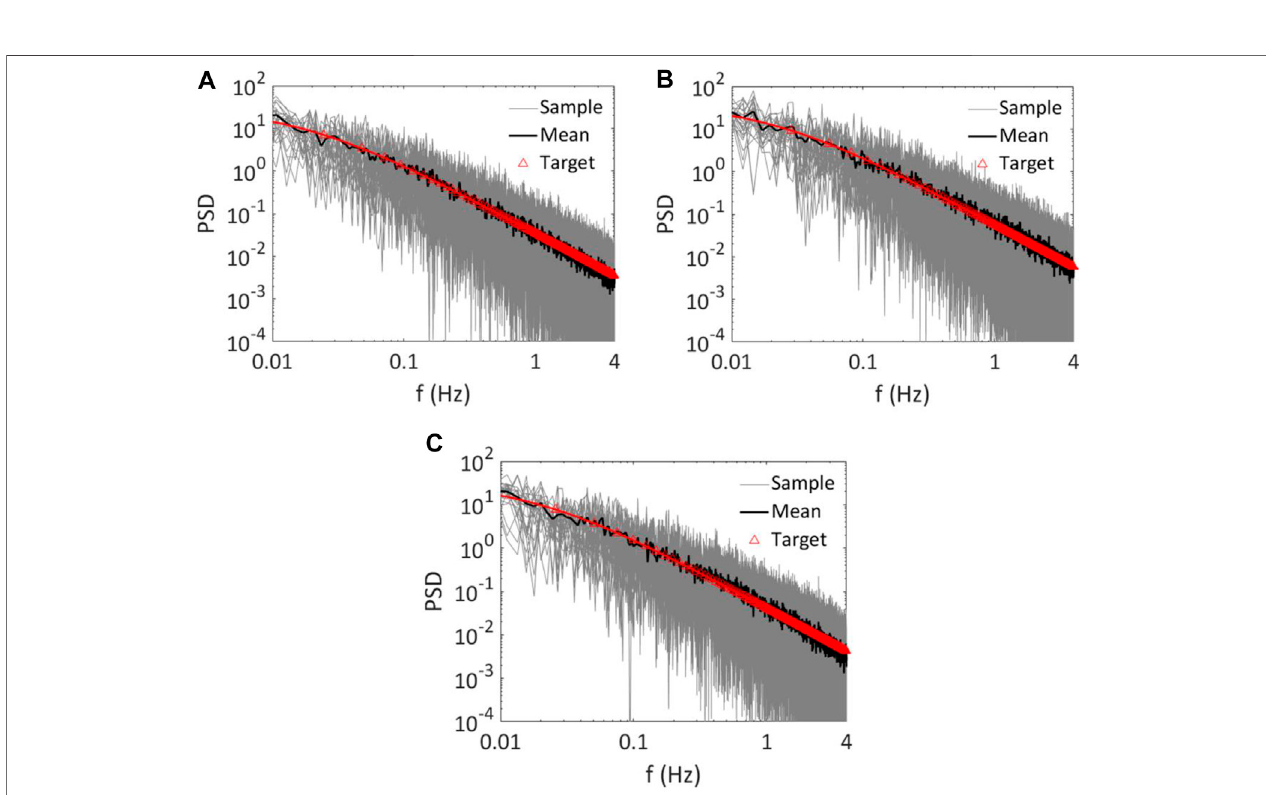
FIGURE 3 | Comparison of the estimated power spectral density function (m 2 /s 2 ) at three points along bridge deck by using 25 runs: (A) at the left pylon, (B) at 200 m from the left pylon and (C) at 400 m from the left pylon.